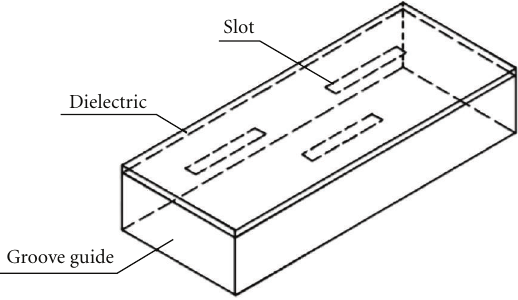
Figure 7: The structure of the